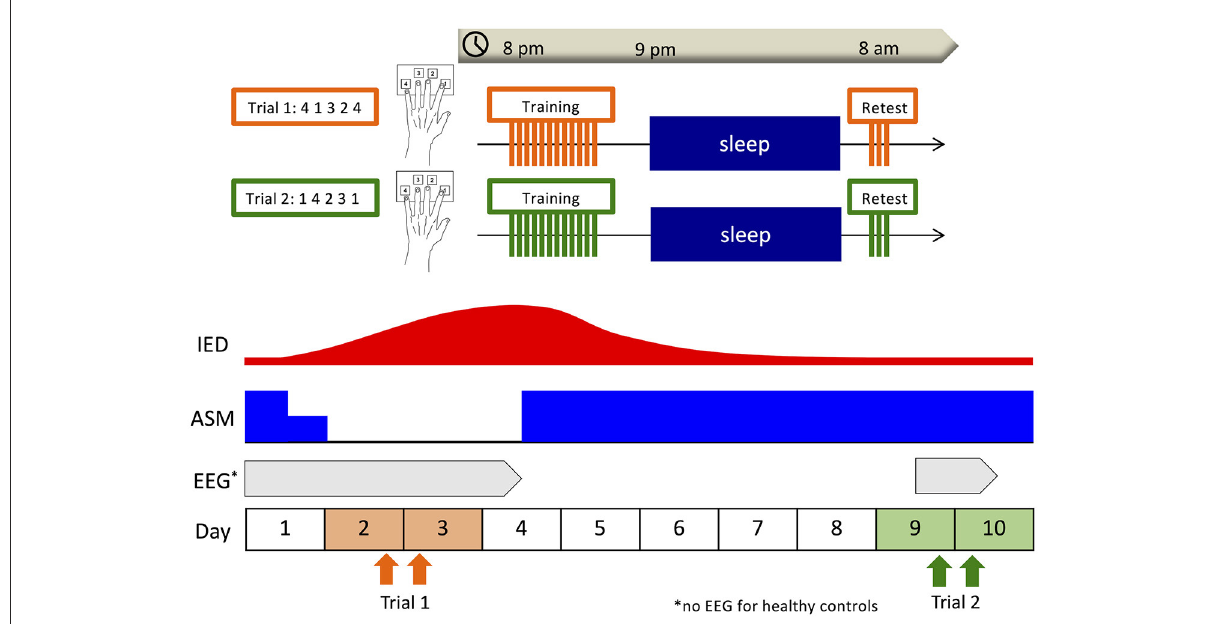
FIGURE1 Overall design. Subjects underwent the training session of the finger-tapping task at 8:00 p.m., and the retest session at 8:00a.m. the next morning. In the patient group, the first trial was conducted on the second night of hospitalization when antiseizure medications (ASMs) were withdrawn for clinical necessity (Trial 1), and the second trial was conducted on the ninth night of hospitalization after ASMs had been returned to usual doses (Trial 2). In the healthy control group, the start date of Trial 1 was set according to the subject’s convenience, and Trial 2 was conducted 1 week later. In the patient group, overnight electroencephalography (EEG) was recorded including the nights after each training session as part of long-term